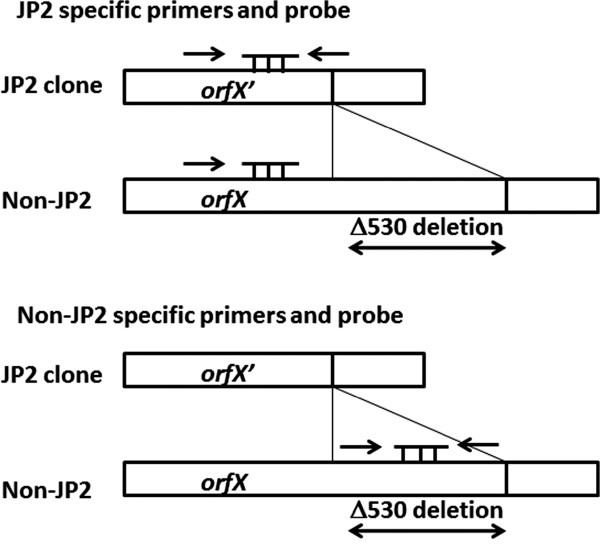
Designation of the oligonucleotide primers and probes specific to the JP2 clone (above) and non-JP2 strains (below). For the JP2-specific amplification, the sense primer and hydrolysis probe are complementary to orfX' (for JP2 clone) and orfX (for non-JP2 strains). The antisense primer was designed to be complementary to the border of the 3' end of orfX' for the specific amplification of JP2 clones. For non-JP2-specific selection, the sense and antisense primers and TaqMan probe were designed to be complementary to the orfX ∆530 region